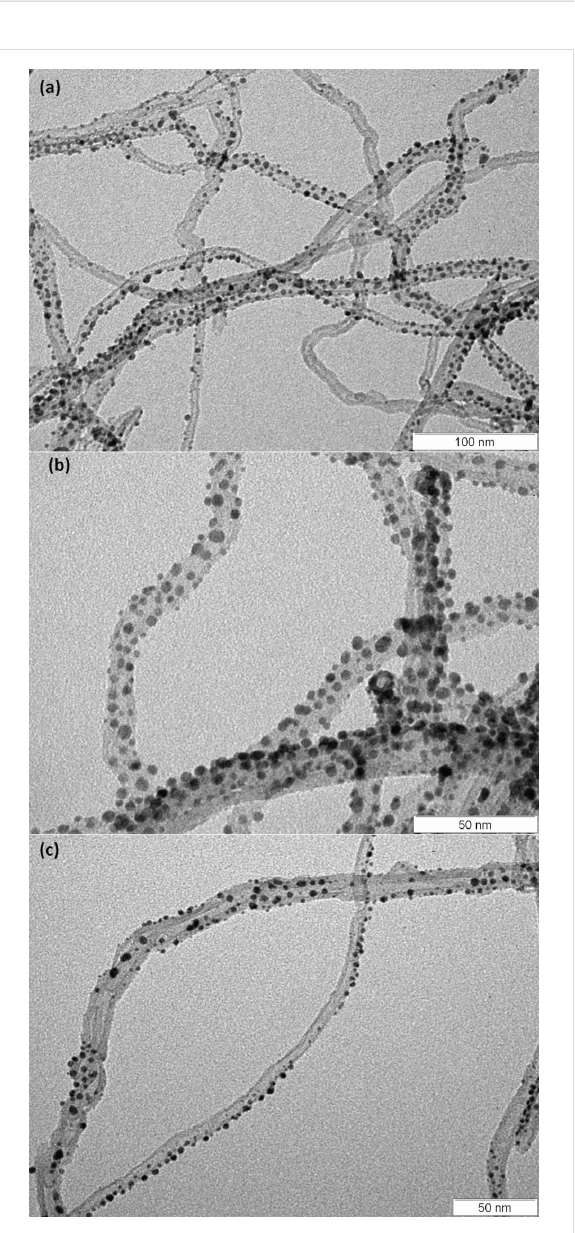
Figure 2: HRTEM image of MWCNTs decorated with Au nanoparti- cles at a magnification of (a) 300 K, (b) 600 K and (c) 400